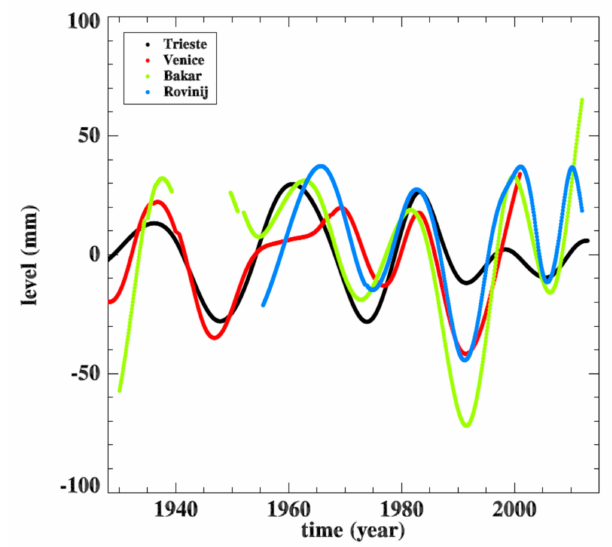
Figure 4. EMD reconstruction by using IMFs with timescale > 15 years (the residue r n ( t ) has not been added up) for the four closest stations in the North Adriatic